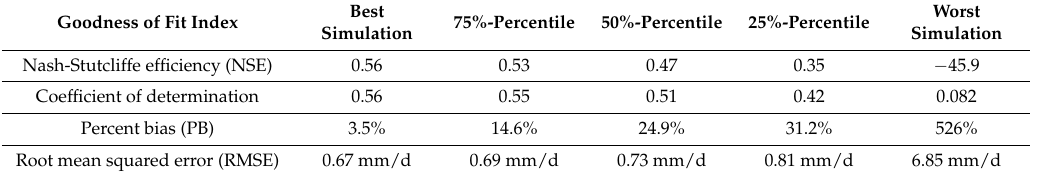
Table 2. Statistical analysis of the goodness-of-fit criteria of the best simulations of each